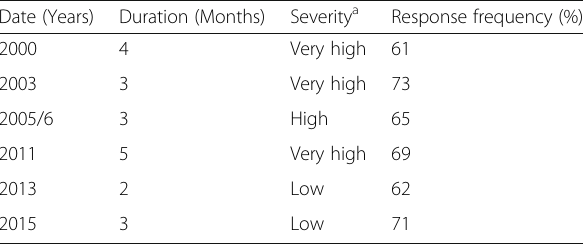
Table 2 Drought occurrences in Trans-Mara East sub-county from 2000 to 2015